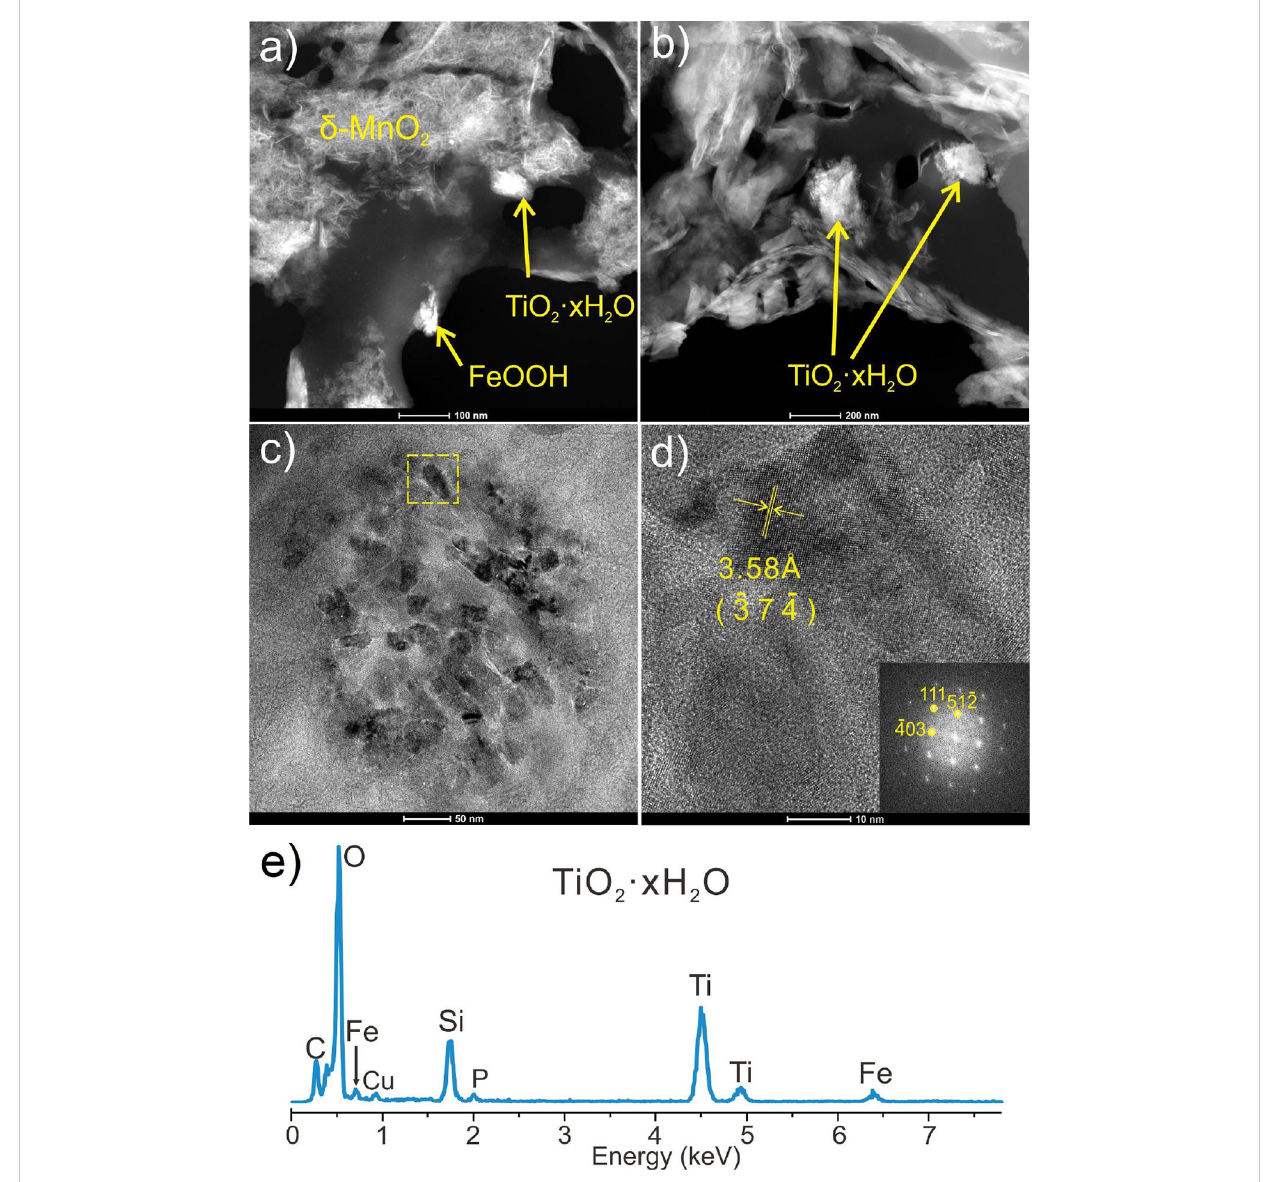
FIGURE 8 TEM photos, SAED and EDS patterns of nano-minerals in samples ST1 and ZJ86. (A, B) under the TEM dark fi eld. (C) under bright fi eld. (D) , high resolution image of the yellow dotted-line frame. (E) the energy spectra of the area inside the yellow dotted-line